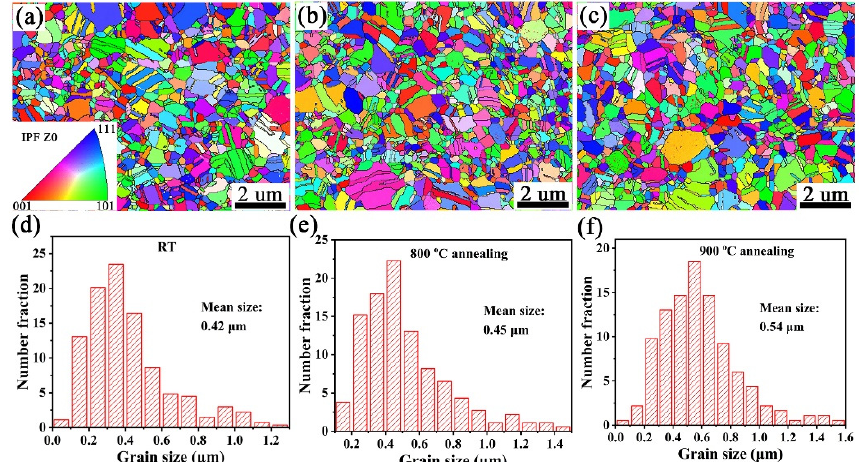
Figure 4. EBSD images of ( a ) SPSed Cu-1wt%Y 2 O 3 sample and the ones annealed at ( b ) 800 °C and ( c ) 900 °C, and ( d – f ) is the corresponding particle size distribution of ( a – c ).